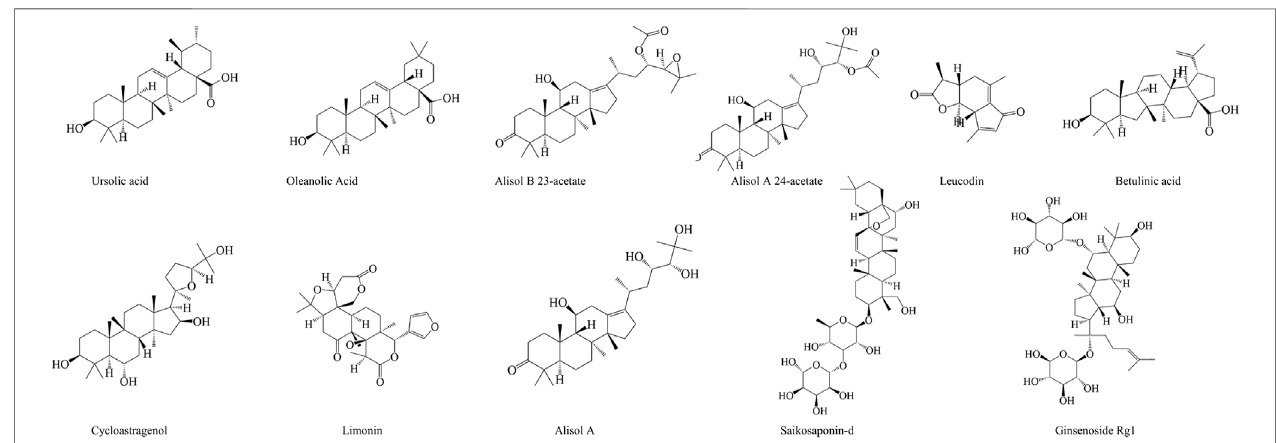
FIGURE 7 | The chemical structures of terpenoids showing anti-hepatopathy activity.